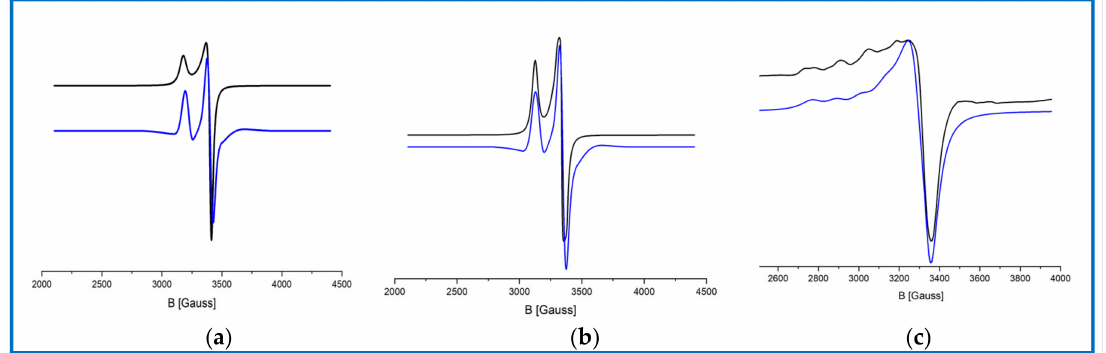
Figure 8. The EPR spectra of complex 1 recorded for polycrystalline powder at ( a ) room temperature (RT), ( b ) temperature of 77 K (LNT) (black line), and ( c ) frozen water solution, paired with the simulated EPR spectra (blue